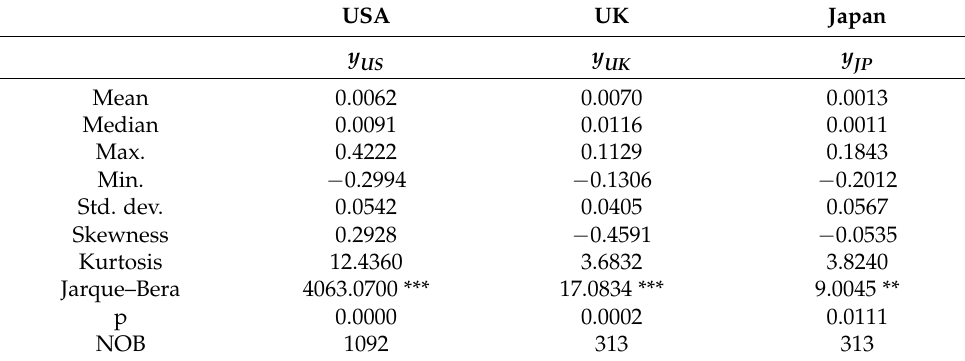
Table 1. Descriptive